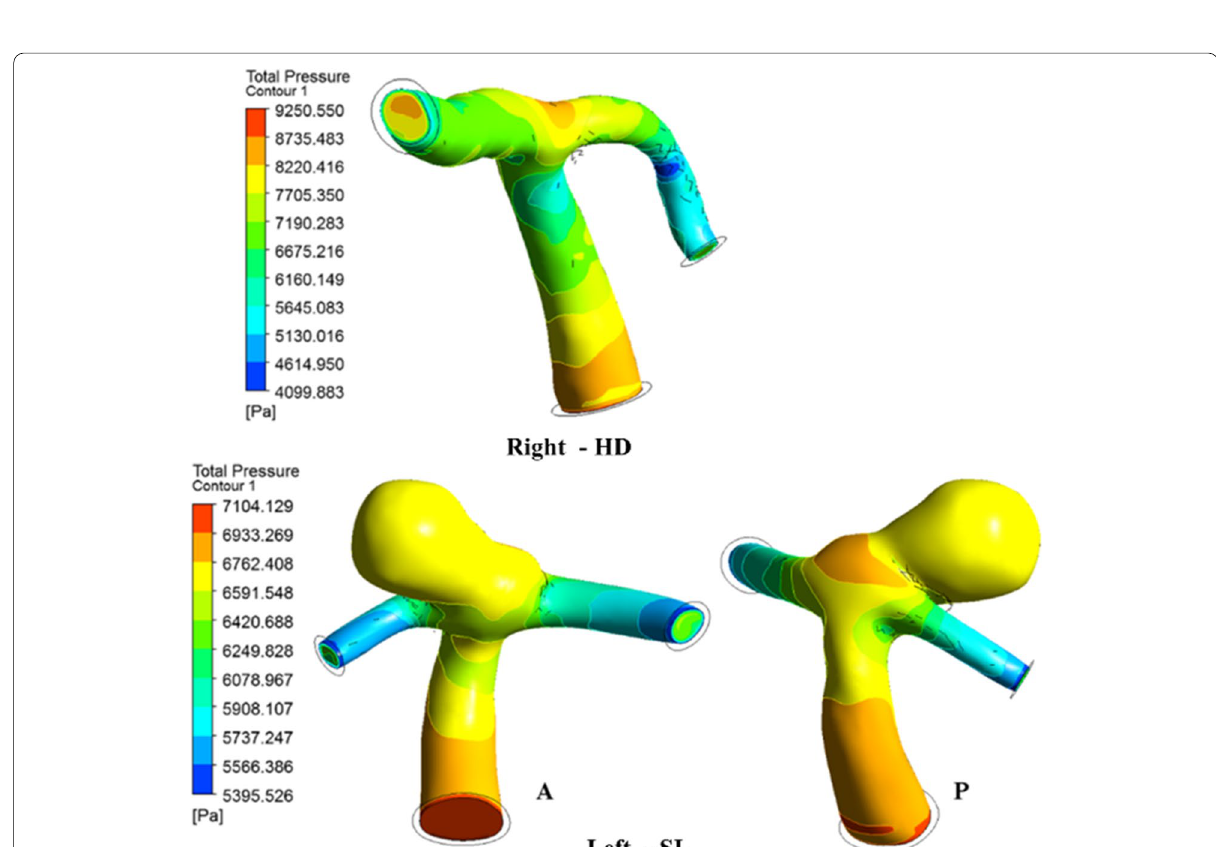
Fig. 10 Comparison of pressure contours during peak